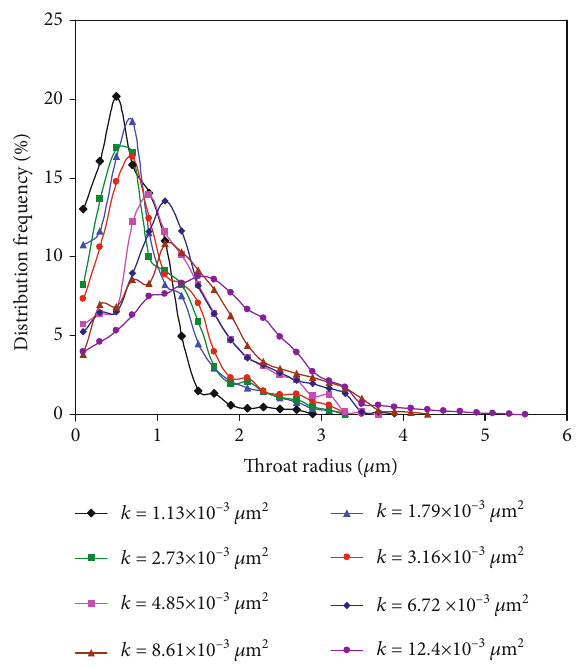
Figure 2: Throat radius distribution of the di ff erent low- permeability cores.